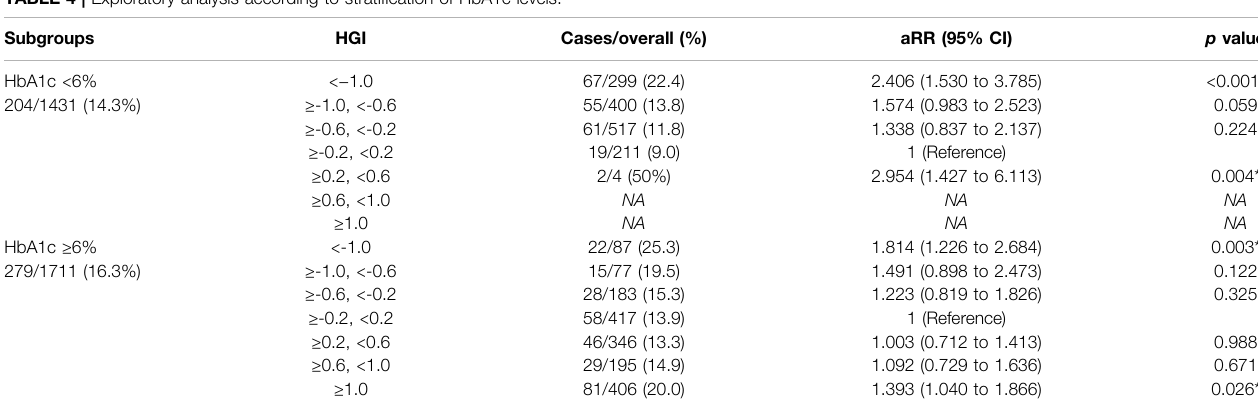
TABLE 4 | Exploratory analysis according to strati fi cation of HbA1c levels. Subgroups